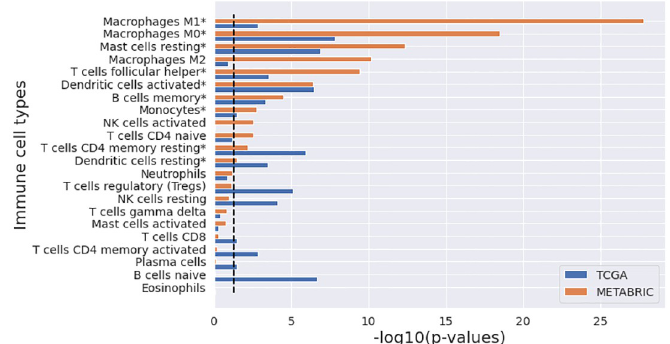
Fig 6. Comparison of 22 immune cell types in CIBERSORT among the four clusters identified in METABRIC and TCGA studies. The black dot line indicates -log10(p = 0.05).